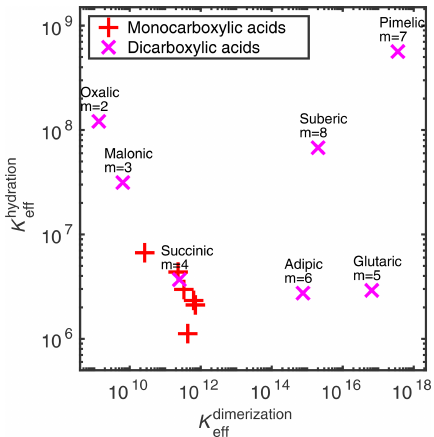
Figure 3. Dimensionless effective equilibrium constants of acid dimer and hydrate formation ( K dimerization and K hydration , respec- eff eff tively) in condensed phase, at 298.15K. See Table 2 for the values. Table 2. Dimensionless effective equilibrium constants ( K eff ) of cluster formation in condensed phase at